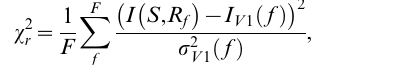
Figure S2 Frequency correlations across naturalistic stimuli. (A) Joint information and (B) Redundancy for frequency pairs. Figure S3 Effects of input parameters modulations on information content of LFP when naturalistic stimuli are injected. In all panels the black line corresponds to the combination of parameters value used in the Results sections, and the red dashed line to significance threshold (p , 0.05; bootstrap test). (A) Information associated to each frequency when parameter k in Equation 10, corresponding to the signal baseline, was varied. (B) Same as (A) when parameter t n in Equation 11 was varied. The different values correspond to a stronger noise in the range 0–5 Hz (green line), 0–10 Hz (black line), 0–20 Hz (blue line). (C) Same as (A) when parameter s n in Equation 11, describing the amplitude of noise fluctuations, was varied. Figure S4 LFP Models. (A) Comparison of spectra of LFP recorded in V1 of anesthetized monkey watching natural movie scenes and spectra of different LFP models when the network was injected with naturalistic signals based on LGN activity recorded in the same experiments. Gray area represents the mean 6 std range of power across 7 different electrodes recording synchro- nously from different sites. The colored lines are spectra obtained with the following LFP models: average membrane potential (green line), sum of absolute value of AMPA currents on pyramidal neurons (pink), sum of absolute values of AMPA and GABA currents on pyramidal neurons (black), and the same sum with a weight 2 assigned to GABA currents (orange). Spectra are averaged over all trials and scenes. (B) Comparison of information content of the spectrum of recorded and simulated LFPs. Same data sets and color code as (A). Red dashed horizontal line indicates significance threshold (p , 0.05, bootstrap test). Found at: doi:10.1371/journal.pcbi.1000239.s004 (0.62 MB